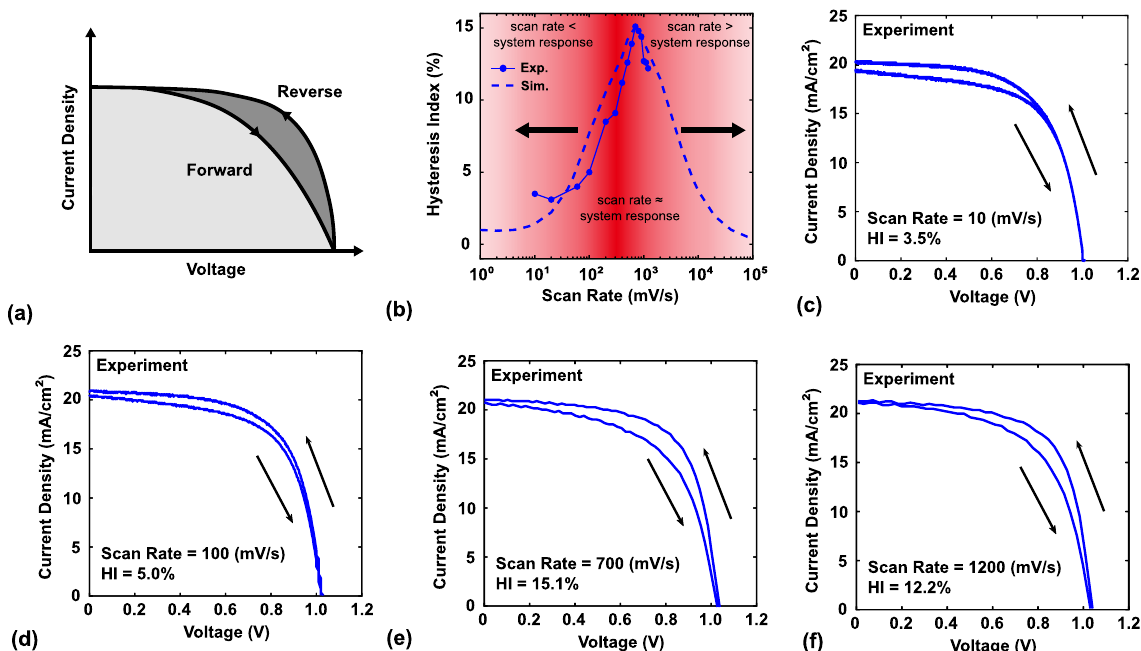
Figure 2. ( a ) Schematic showing the definition of hysteresis index. ( b ) Change in hysteresis factor with scan rate, the solid line and dash line are experiment and modeling results, respectively. ( c – f ) J – V characteristics in experiments at scan rates of 10, 100, 700, and 1200 mV/s,